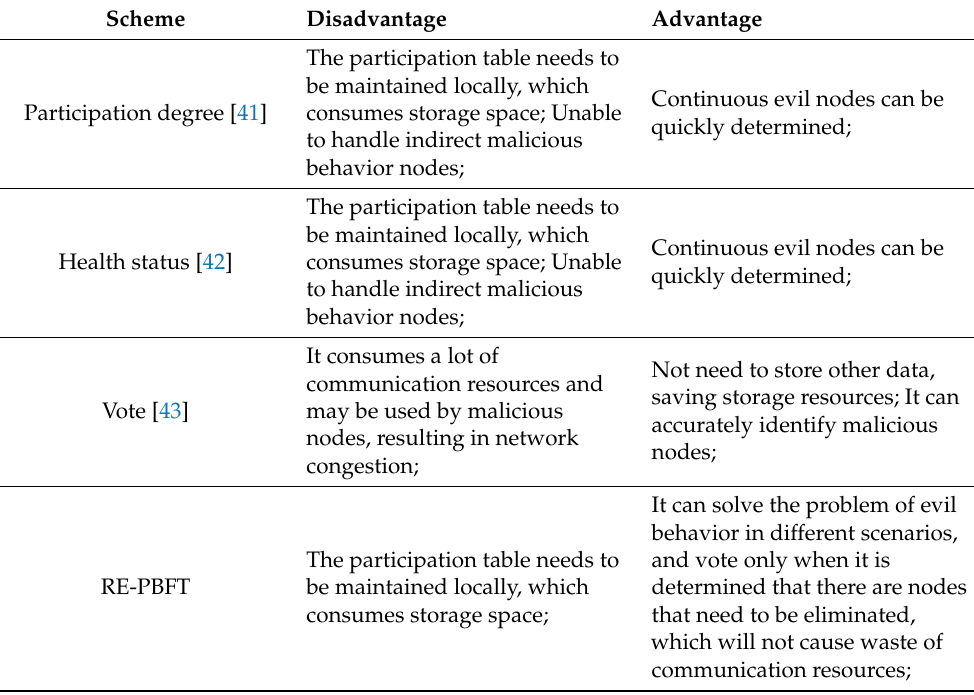
Table 3. Comparison of node elimination